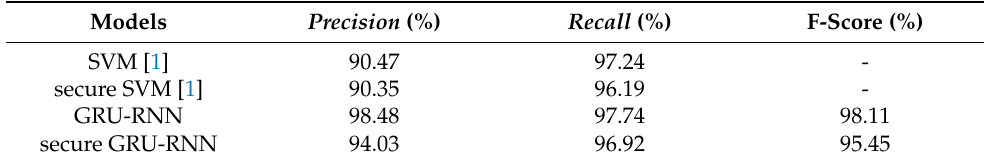
Table 3. Parameter comparison of the WDBC dataset.